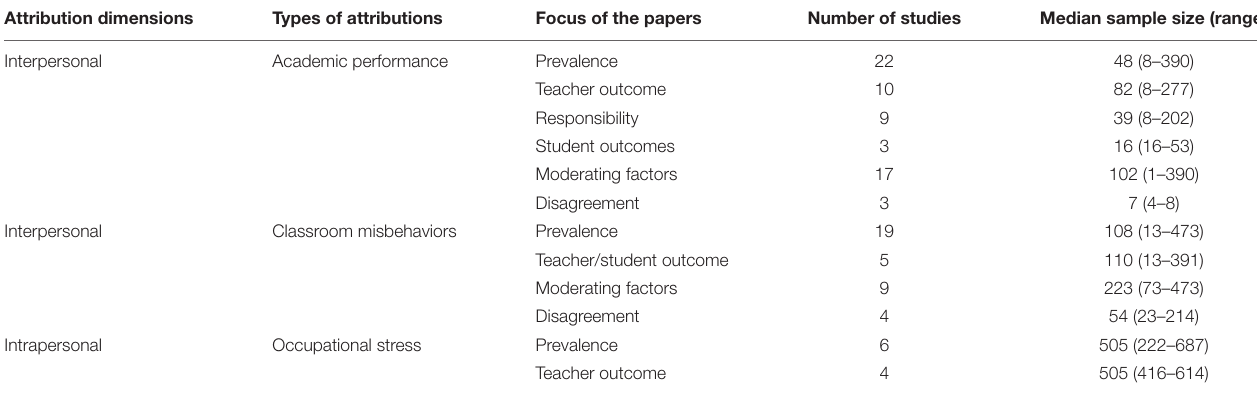
TABLE 3 | Overview of study outcomes, domains, and